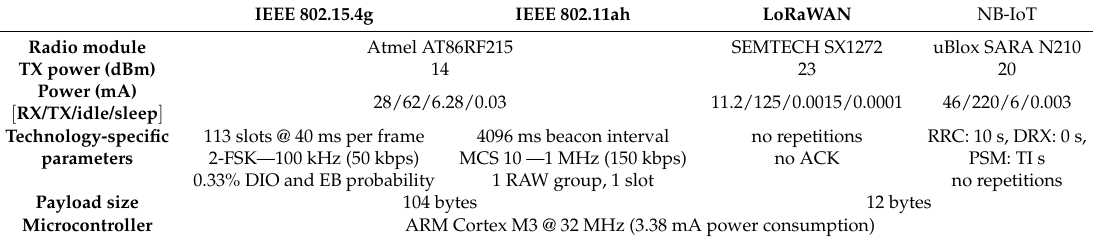
Table 4. Technology-specific parameters for energy consumption